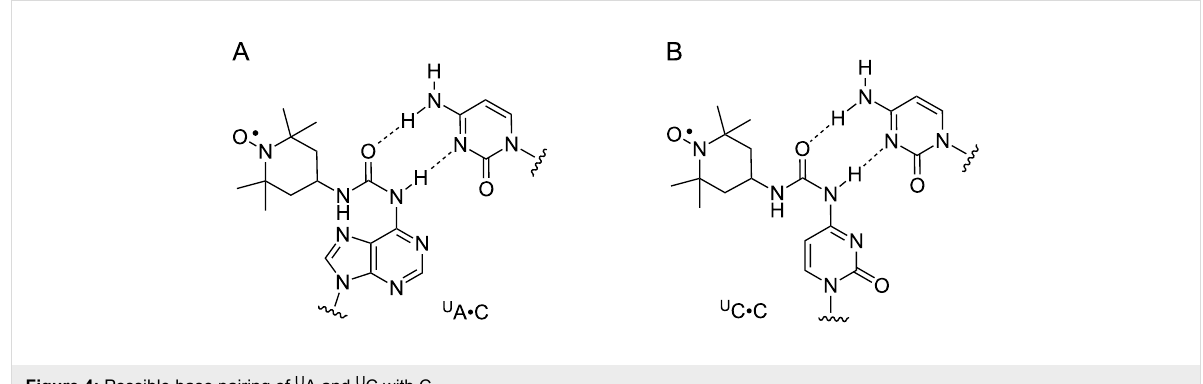
Figure 4: Possible base pairing of U A and U C with